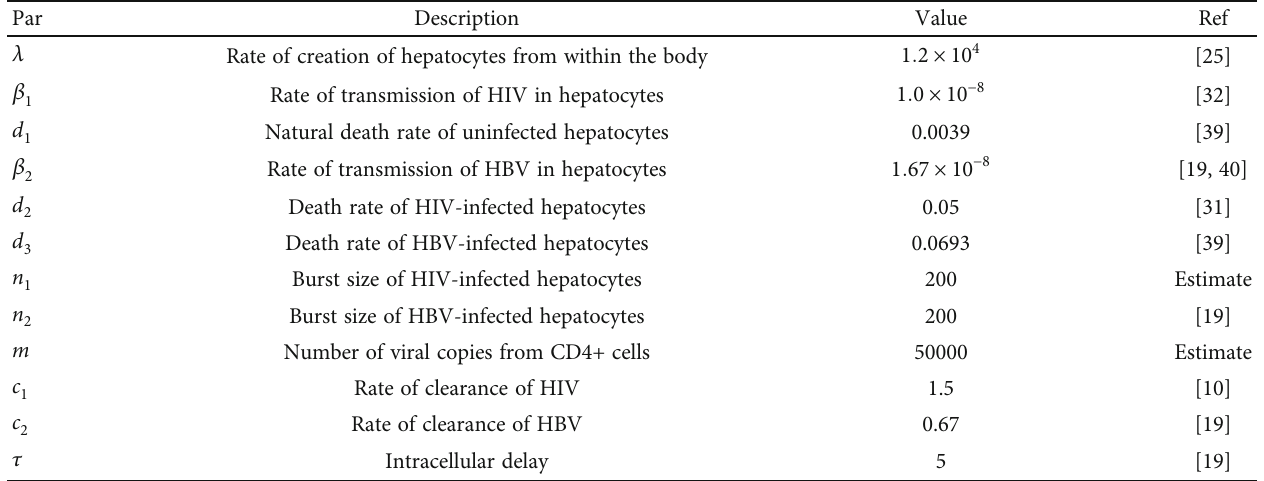
Table 1: Parameters values used in